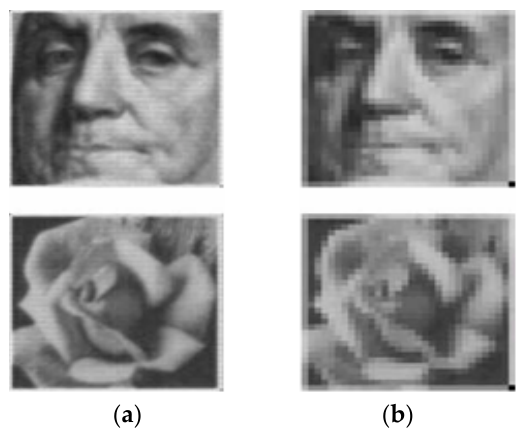
Figure 2. Pixel sub-sampling technique ( a ) high-resolution mode; ( b ) low-resolution mode.